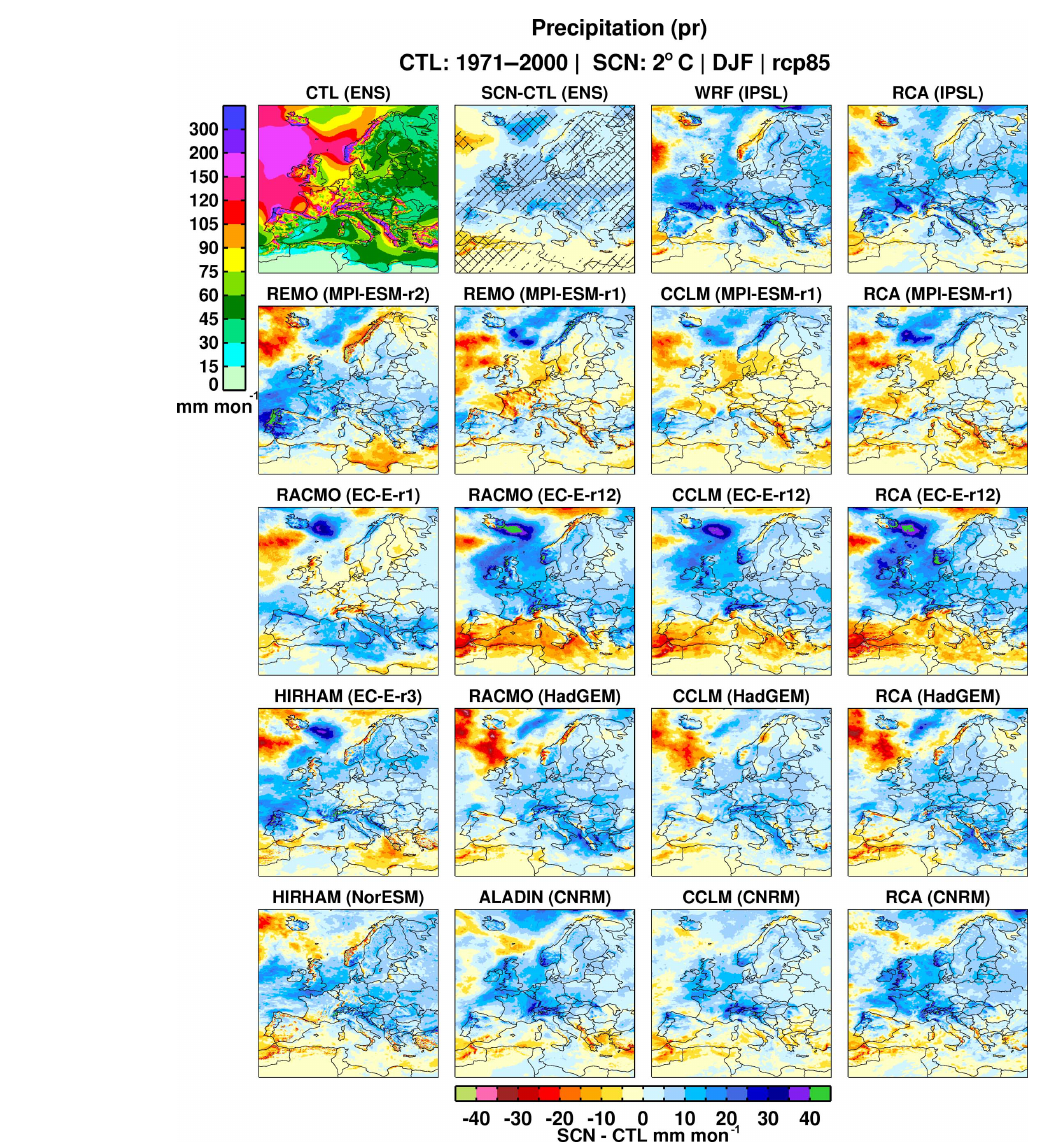
Figure 6. Winter (DJF) precipitation in the reference period (ensemble mean in the uppermost left panel) and its change in 18 RCM simulations in Table 1 (two uppermost right panels and all other rows) for the + 2 ◦ C of warming level (SWL2). Hatching in the ensemble mean signal (second upper panel from the left) represents areas where at least 14 of the 18 ensemble members agree on the sign of change. Cross-hatching indicates that there is agreement on the sign of change and that the signal-to-noise ratio is larger than